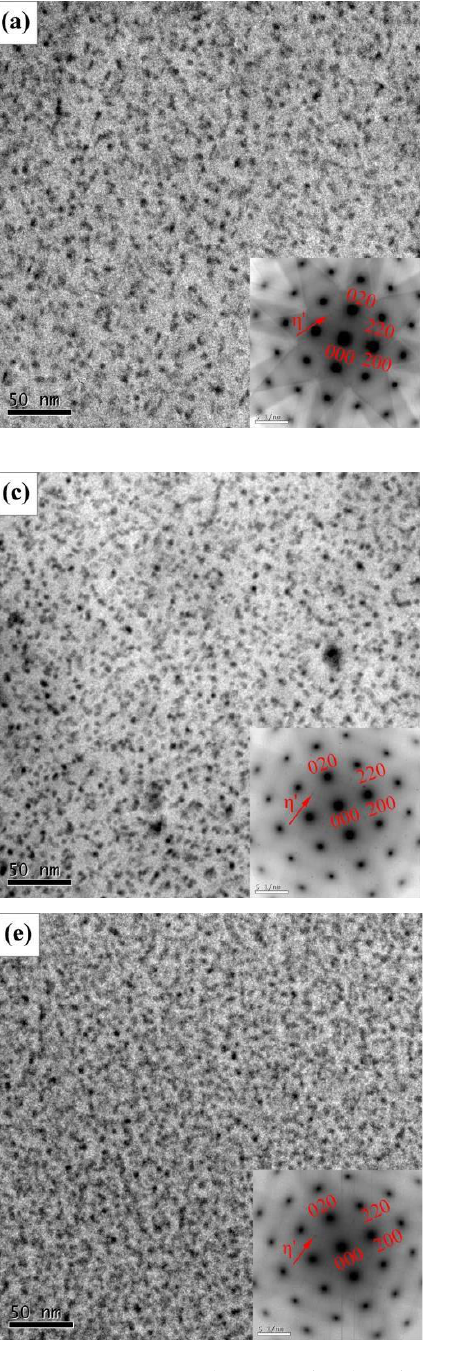
size of η’ phases was measured and proportions of size was obtained through the normal distribution